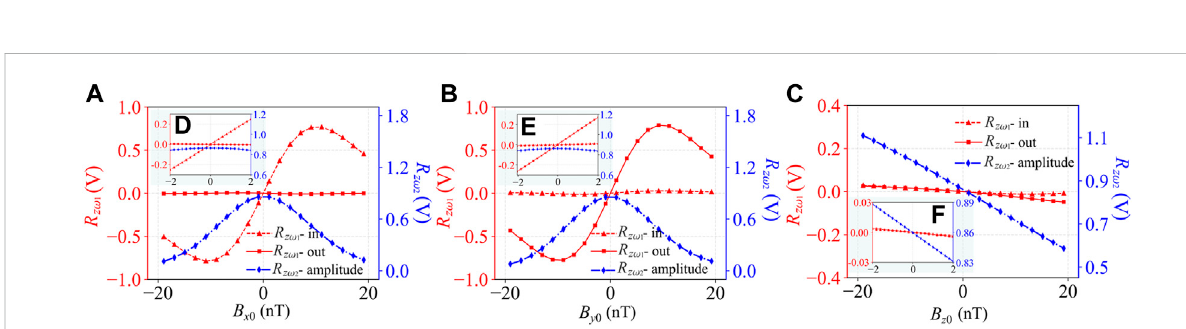
FIGURE 5 Experimental results. Comparison of the dependence properties of the three observables, the in-phase (red triangles) and out-of-phase (red squares) signals of R z ω 1 and the amplitude of R z ω 2 (blue diamonds), on (A) B x 0 , (B) B y 0 , and (C) B z 0 within therange of [-20, 20] nT, respectively. Insets (D – F) show the detailed zoom-in in the vicinity of zero fi eld within the range of [-2, 2]